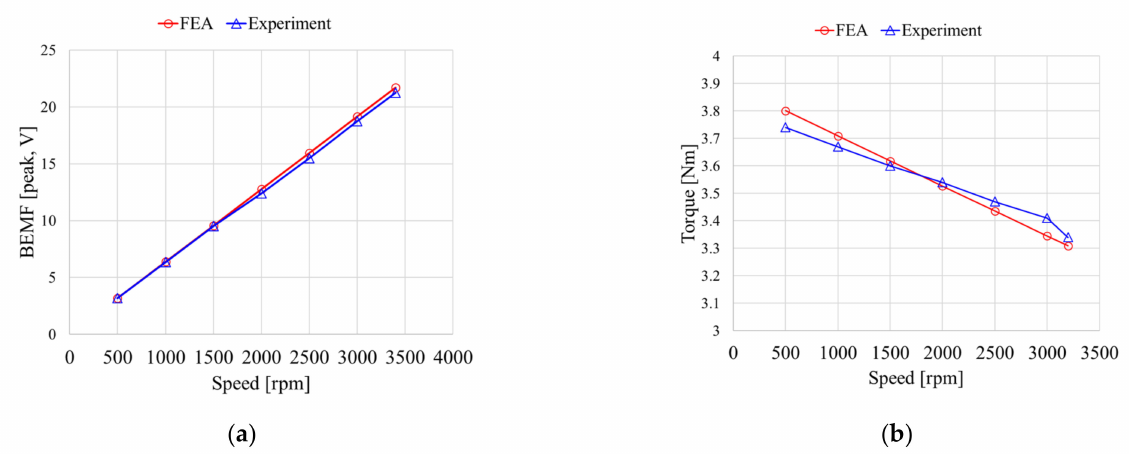
Figure 14. Comparison with experiment and FEA results according to speed: ( a ) BEMF; ( b )